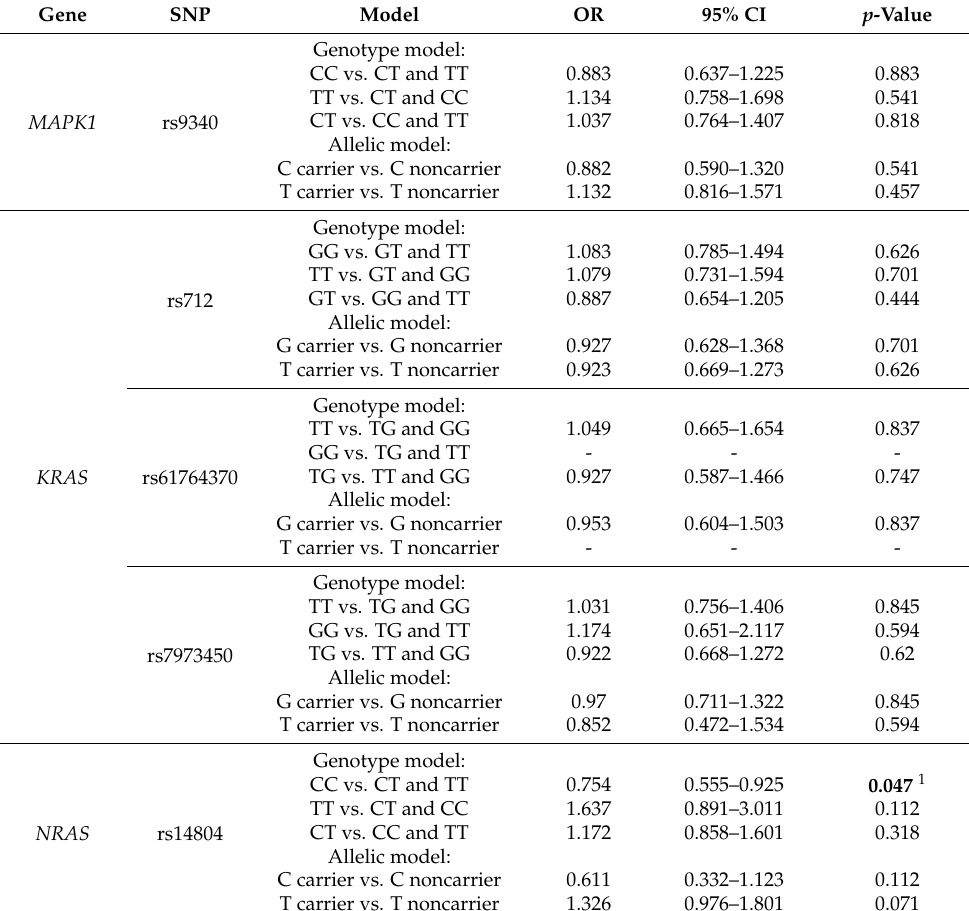
Table 5. Association between KRAS , NRAS , MAPK1 polymorphisms in allele and genotype models and LSCC